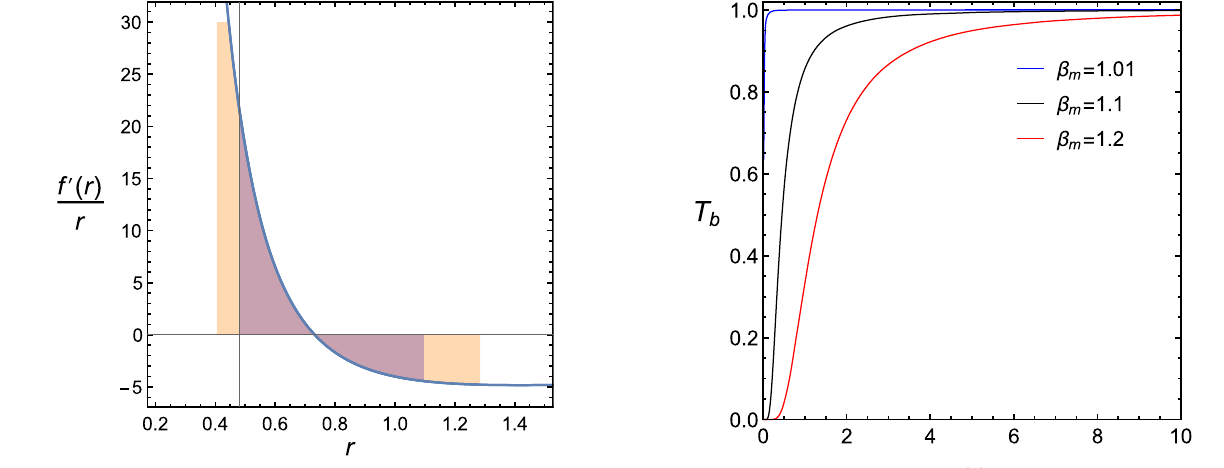
Fig. 4 Plot of f (cid:8) / r using different values of β m , with M = 1 and c 2 = 1. The blue filled area corresponds to β m = 1 . 1 and the orange filled area corresponds to β m = 1 . 2